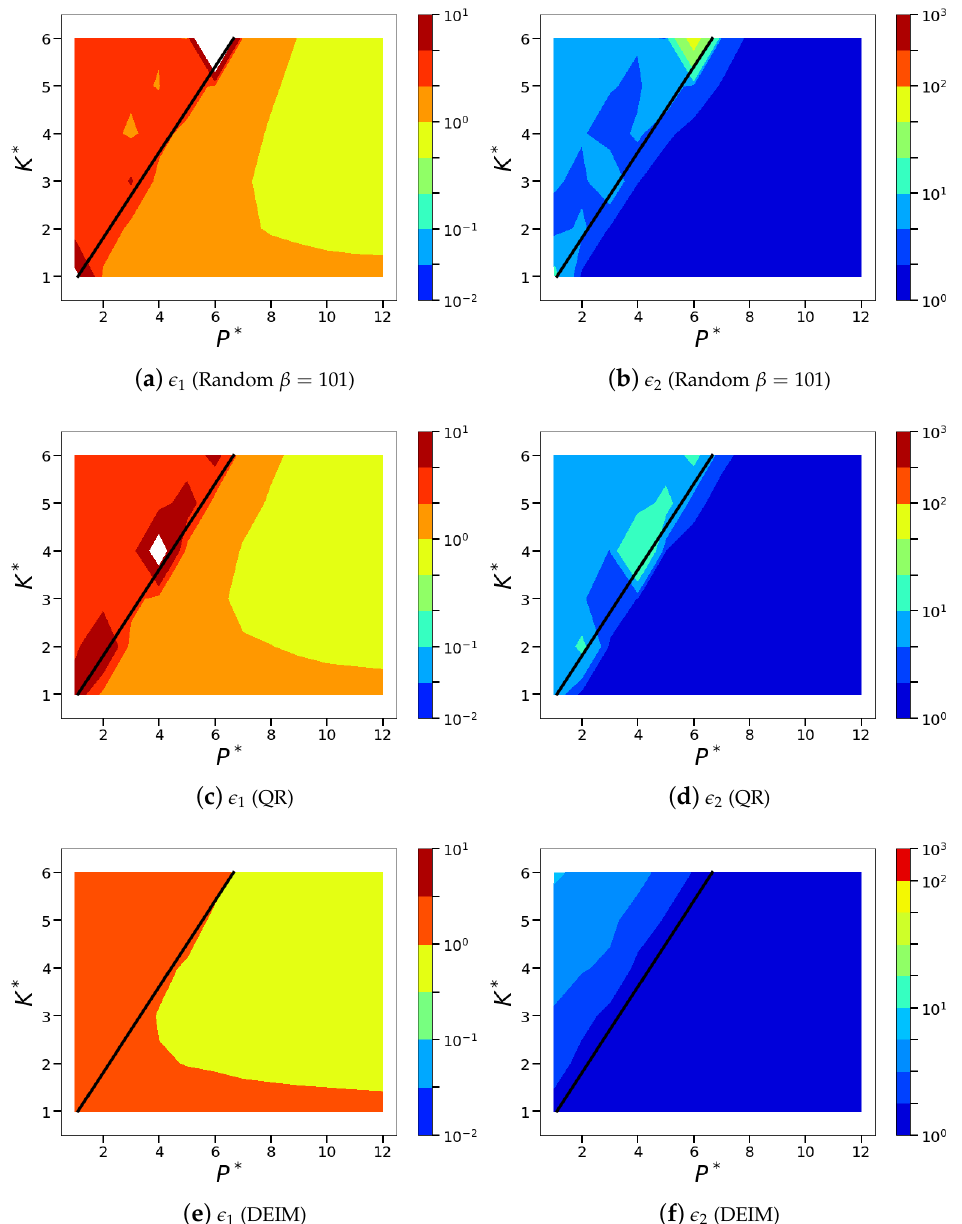
Figure 17. Isocontours of the normalized mean squared POD-based sparse reconstruction errors ( l 2 norm) of sea surface temperature data corresponding to the Random ( a , b ), QR ( c , d ) and DEIM ( e , f ) sensor placement methods. Subfigures ( a , b , e ) show the normalized absolute error metric, (cid:101) 1 and subfigures ( b , d , f ) show the normalized relative error metric, (cid:101) 2 . Overall, the topology of error metrics across the P ∗ − K ∗ design space for the SST data (Figure 17) is similar to that observed for the low-dimensional cylinder wake (Figure 13). In particular, the smaller relative errors ( (cid:101) 2 ) are located in the oversampled region with P ∗ > K ∗ . To remind the reader, (cid:101) 2 is normalized by the error contained in the exact K -dimensional POD reconstruction and represents how effectively the sparse data can approximate the K -dimensional representation of the flow field for the given budget and placement. As expected (cid:101) 1 contours adhere to a L -shaped structure indicating that absolute normalized error reduces as both P and K increase due to oversampling and increased system